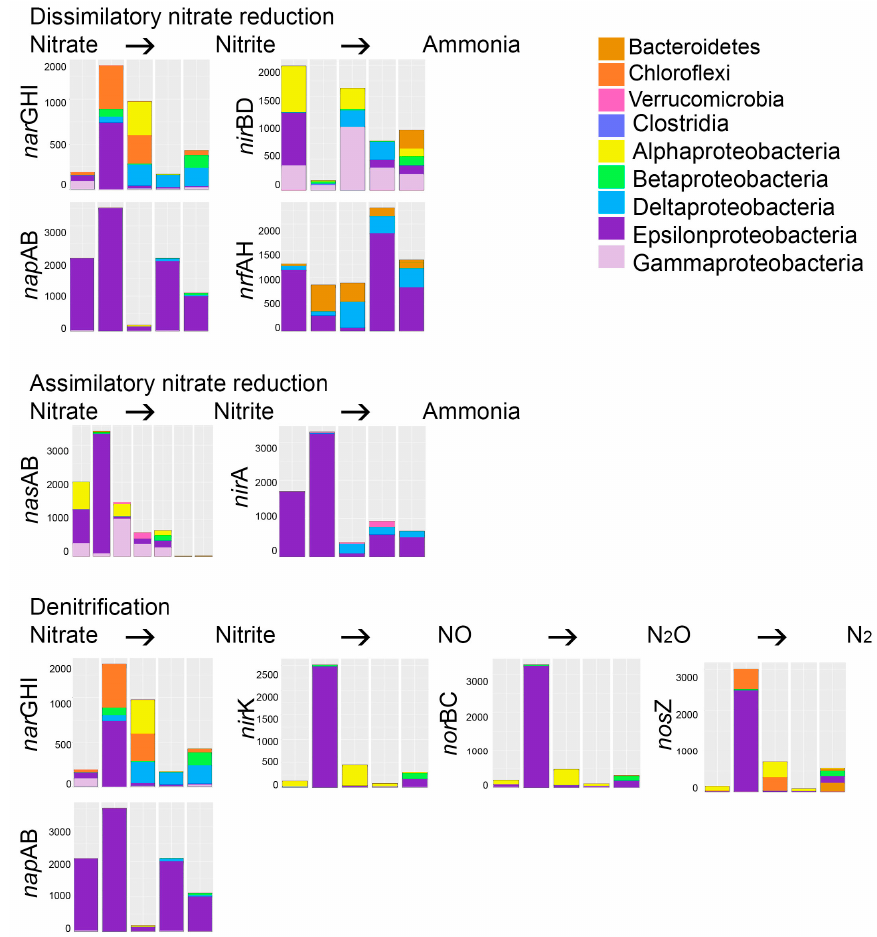
Figure 6. The bacterial groups responsible for the different steps of denitrification and nitrification processes in the bioreactors. The Y-axis shows the number of sequence reads. The taxonomic groups are shown by the color charts in each figure. nar GHI—nitrate reductase, nap AB—periplasmic nitrate reductase, nir BD—nitrite reductase (NADH dependent), nrf AH—nitrite reductase (cytochrome c-552), nas AB—assimilatory nitrate reductase, nir A—ferredoxin-nitrite reductase, nir K—nitrite reductase (NO-forming), nor BC—nitric oxide reductase, nos Z—nitrous-oxide reductase. The columns in each chart from the left; BR1 day 101, BR1 day 140, BR2 day 101, BR3 day 101, BR3 day 140.